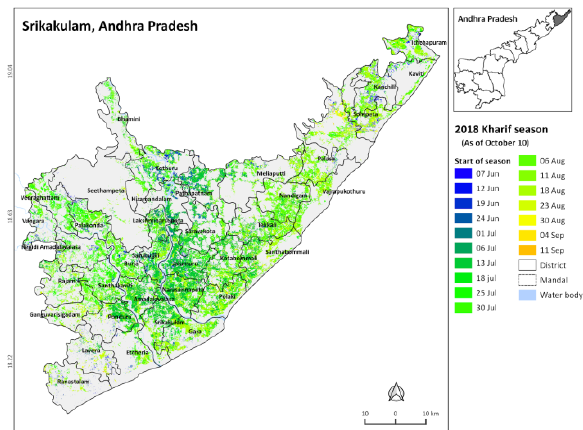
Figure 3. Start of season of rice cultivation in Srikakulam district during kharif 2018.